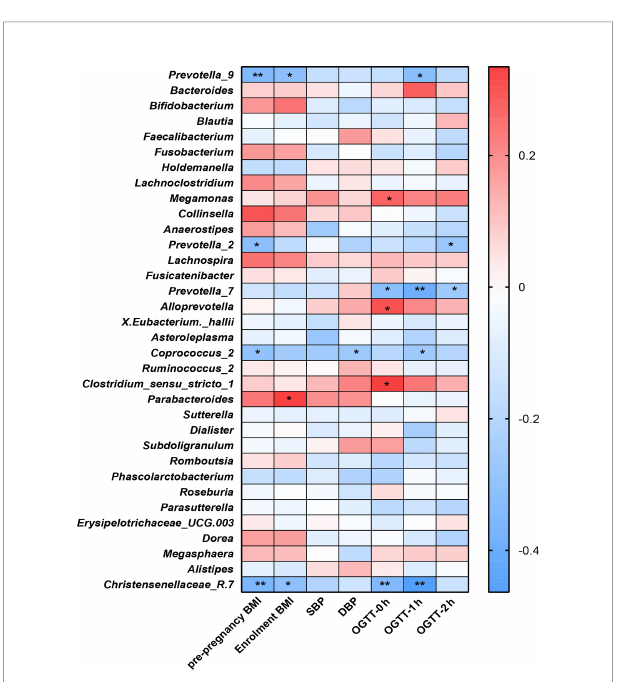
FIGURE 5 | Heatmap analysis of the correlation between the gut microbiota composition and clinical scores. ** P <0.01, * P <0.05.